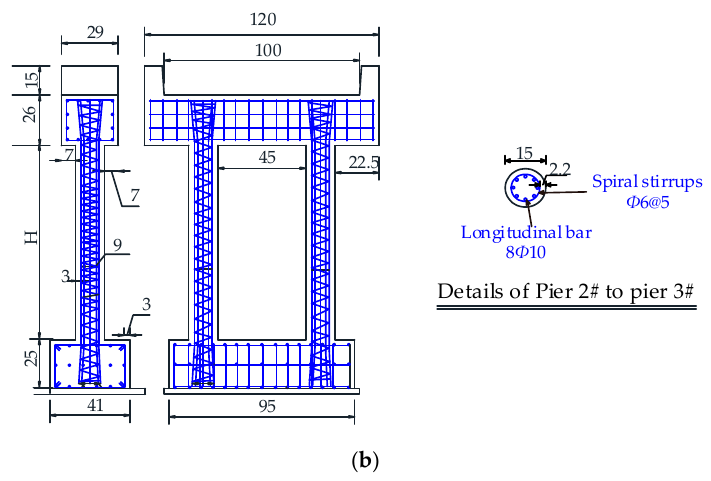
Figure 1. Bridge model design (unit: cm): ( a ) superstructure; ( b ) substructure.